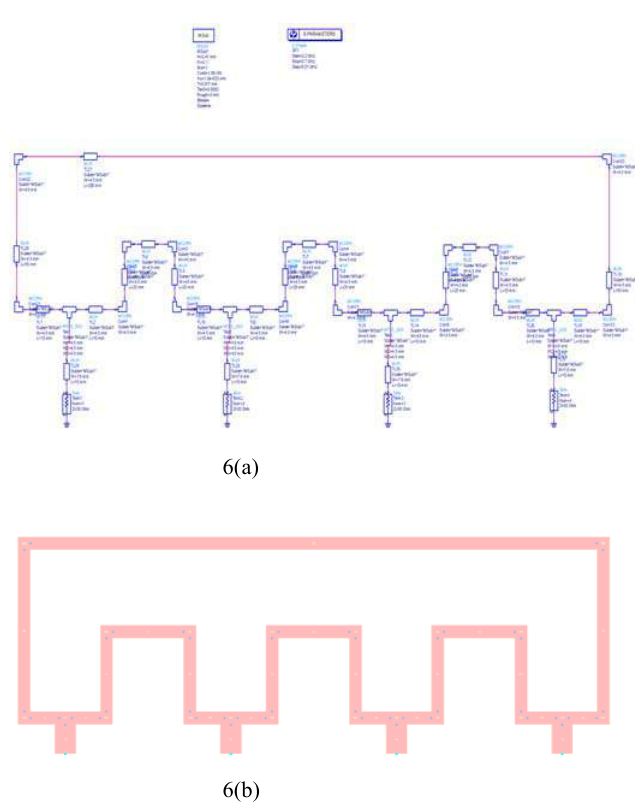
Fig. 6: Simulation model of micro strip compact Rat-Race coupler (a) Schematic (b)